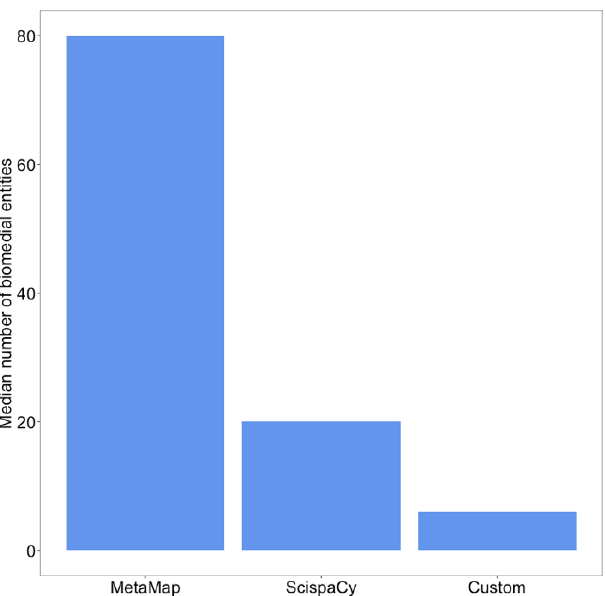
Figure 3. Median number of biomedical entities recognized by three biomedical information extrac- tion tools .